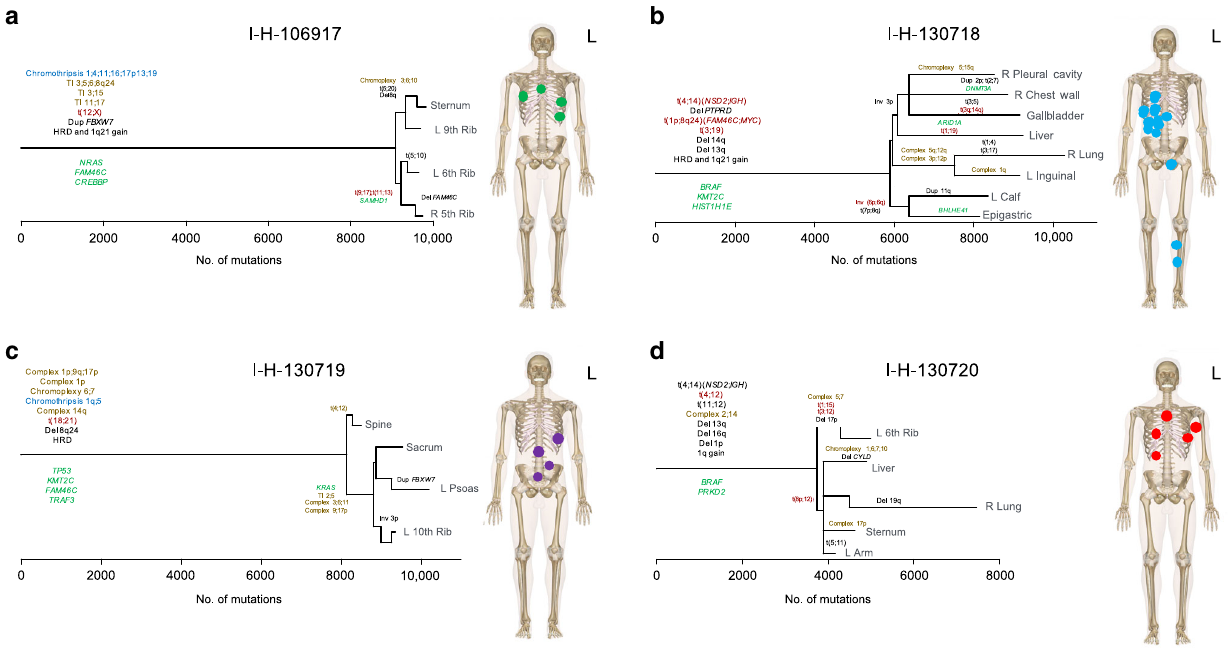
Fig. 3 Tumor phylogenies. Phylogenetic trees generated from the Dirichlet process analysis were drawn such that the trunk and branch lengths were proportional to the (sub)clone mutational load, a I-H-106917, b I-H-130718, c I-H-130719 and d I-H- 130720. All main drivers (CNA, copy number aberrations; SNV, single nucleotide variants and SV, structural variants) were annotated according to their chronological occurrence and colored according to the type of event. Known driver SNVs were annotated in green, single SVs and CNAs in black (HRD = hyperdiploid), translocations associated with copy number changes in dark red, chromothripsis in blue, other complex events in dark yellow, (TI = templated insertion). Lines from different subclone branches are separated by hooks. Patients with short survival are positioned on the right (I-H-130718 and I-H-130720). L =